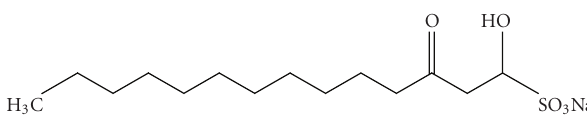
Figure 1: Chemical structure of sodium lauryl sulfoacetate.